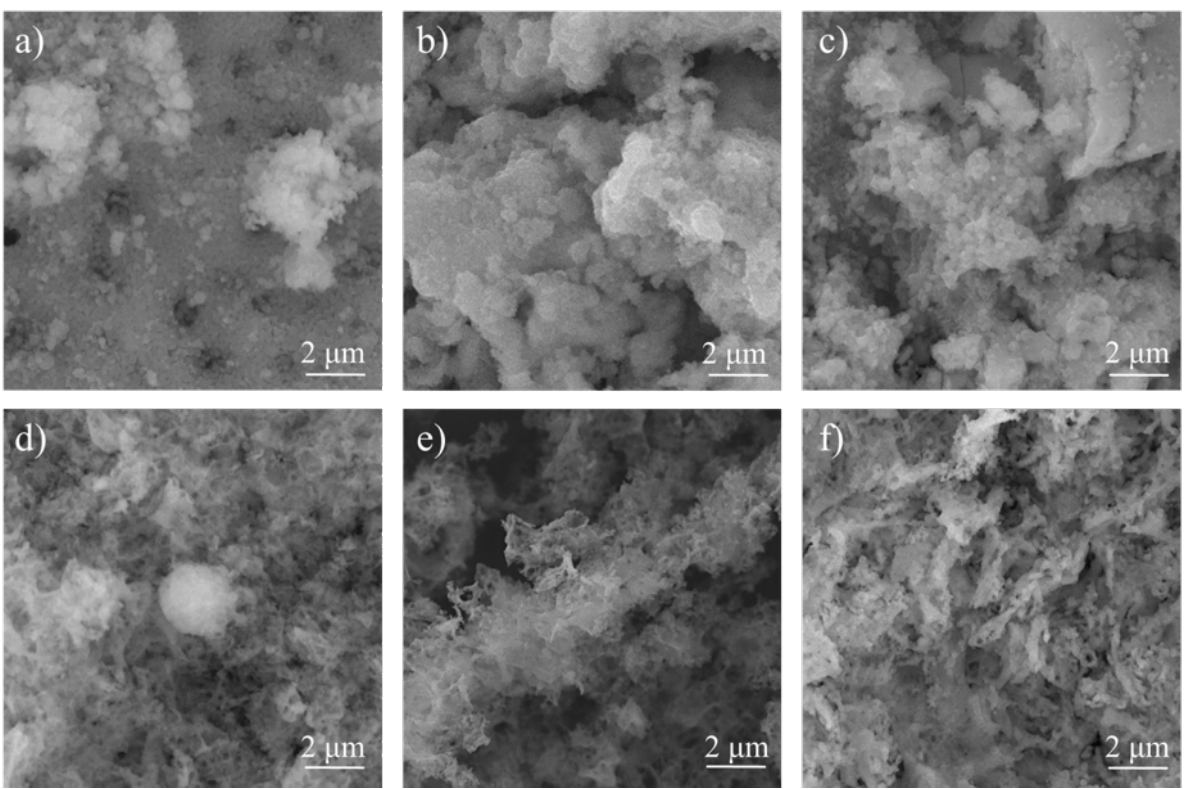
Figure 5: SEM micrographs of CeO 2 /CuO nanocomposites with the following fuels used: a) urea; b) glycine; c) urotropine; d) ascorbic acid; e) citric acid; f)